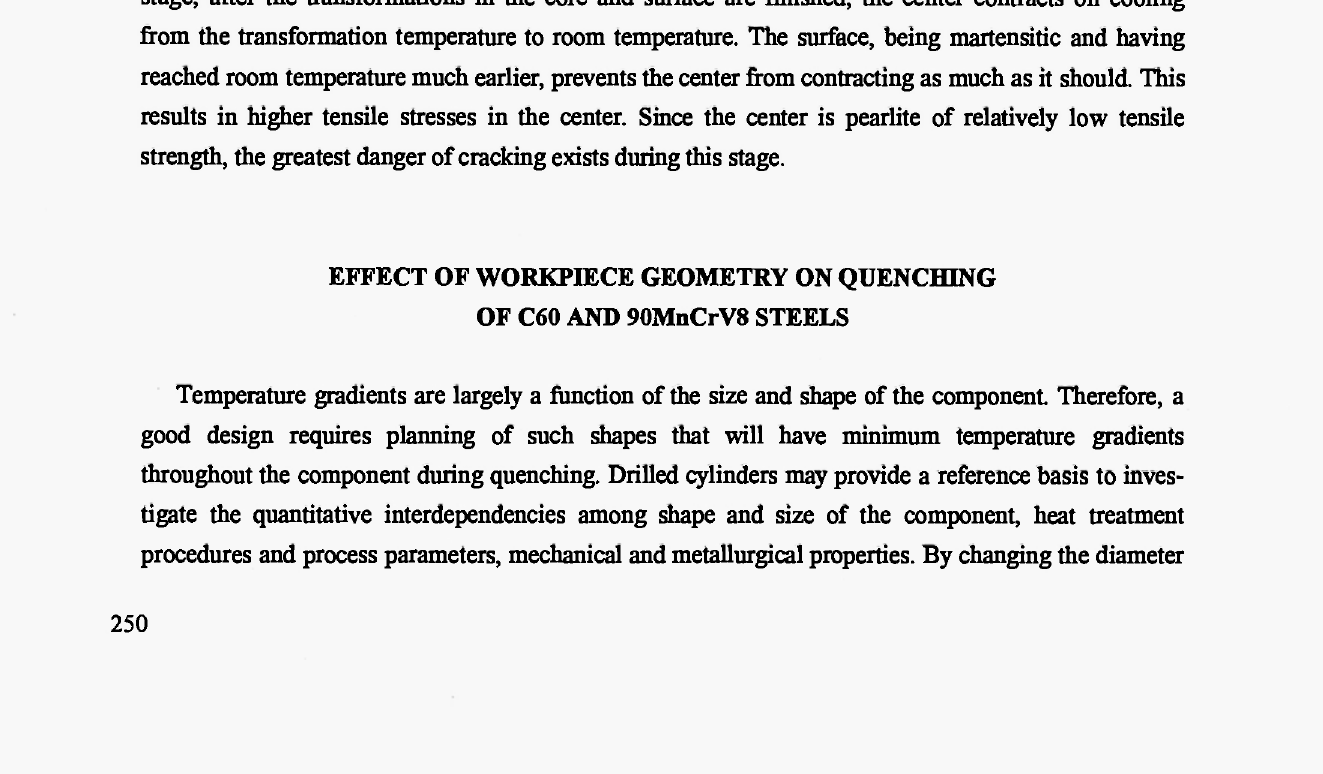
Fig. 6: Phase compositions along the radius in the C60 steel cylinders, quenched from 830°C into 20°C and 60°C